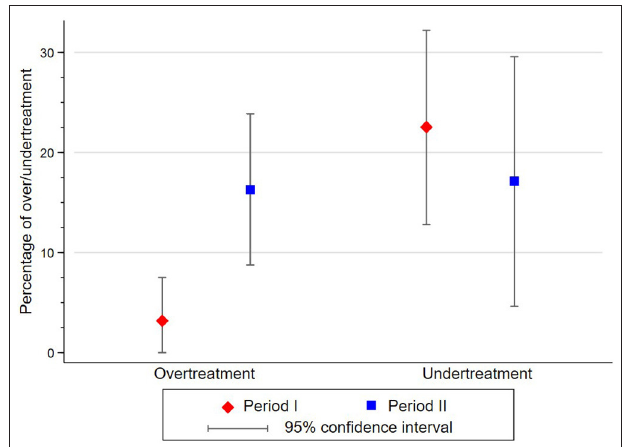
FIGURE 4 | Difference in percentage of cases undertreated and overtreated by HCPs according to mentor diagnosis between period I and period II.